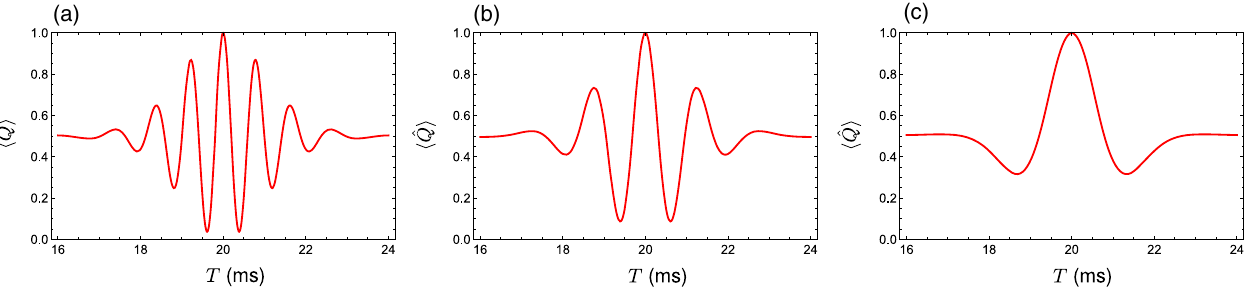
FIG. 9. Expected results for a Ramsey measurement coupling to x ð t Þ ¼ A cos ð 2 π ft Þ , a classical single-frequency noise source. The amplitude A of this single-frequency noise fluctuates on time scales slower than an experimental shot with a Gaussian probability ffiffiffiffiffi p 2 π distribution P ð A Þ ¼ ½ 1 = ð σ Þ(cid:2) e − 1 2 ½ð A − A 0 Þ = σ (cid:2) 2 . The coupling constant is assumed to be 1: ˆ Q h i ¼ h P ðþ 1 Þ − P ð − 1 Þi ¼ − e 1 2 f½ sin ð 2 π fT Þ σ (cid:2) = 2 π f g cos ( ϕ þ ½ A 0 = ð 2 π f Þ(cid:2) sin ð 2 π fT Þ ) , with T given by the Ramsey wait time and ϕ the second Ramsey pulse phase. We show three different amplitudes A 0 : (a) A 0 ¼ 8000 , (b) A 0 ¼ 5000 , and (c) A 0 ¼ 2000 , of the noise, with the noise frequency fixed to 50 Hz, σ ¼ 1000 , ϕ ¼ 0 . The oscillations resemble characteristic traces of Schrödinger cat states, such as those found in Ref.